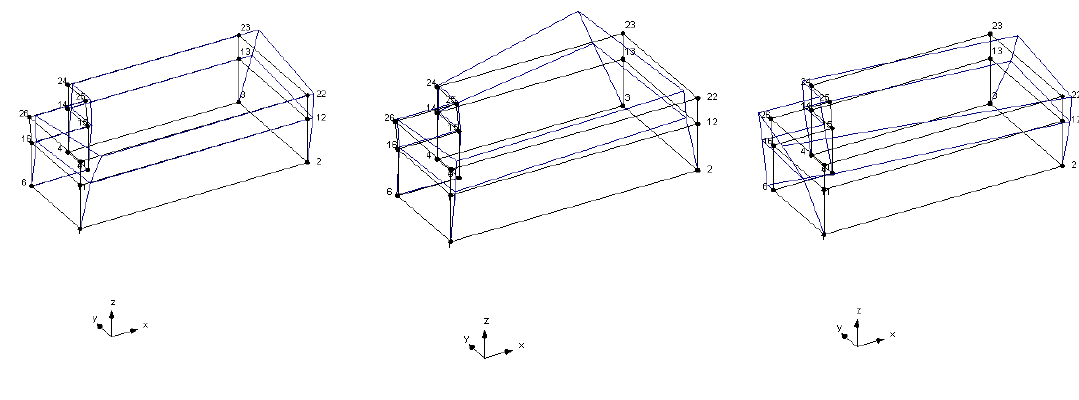
Figure 9. Mode shapes identified using SSI method – Structure A, Test 1.